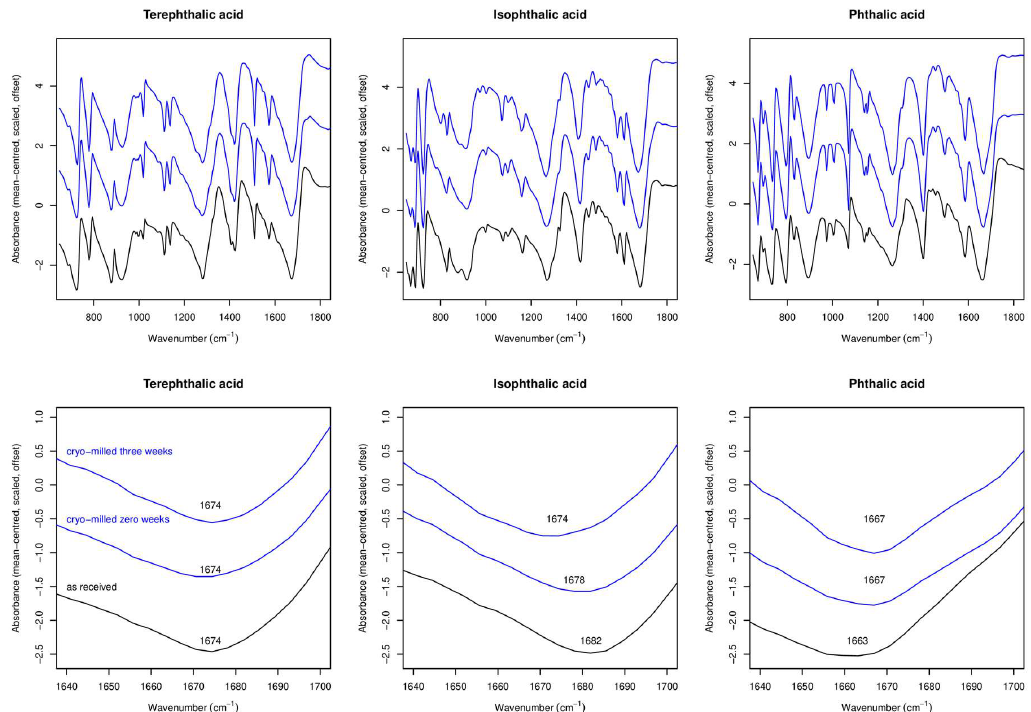
Figure 4. Attenuated Total Reflectance Infra-Red (ATR-FTIR) spectra for: TPA; IPA; and PA, as-received and after cryo-milling.